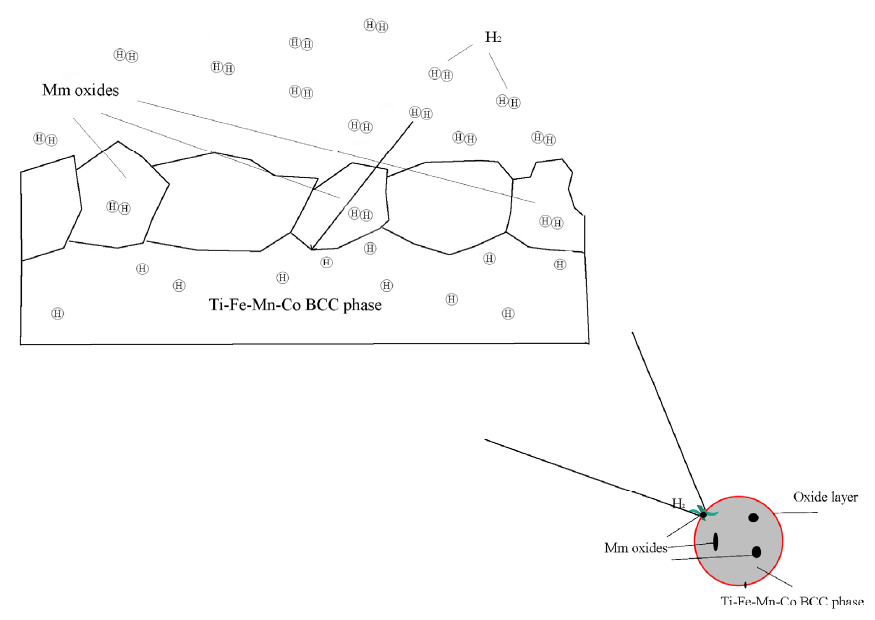
Figure 10. Cyclic stability mechanism of TiFe-based alloys with Mm oxides.